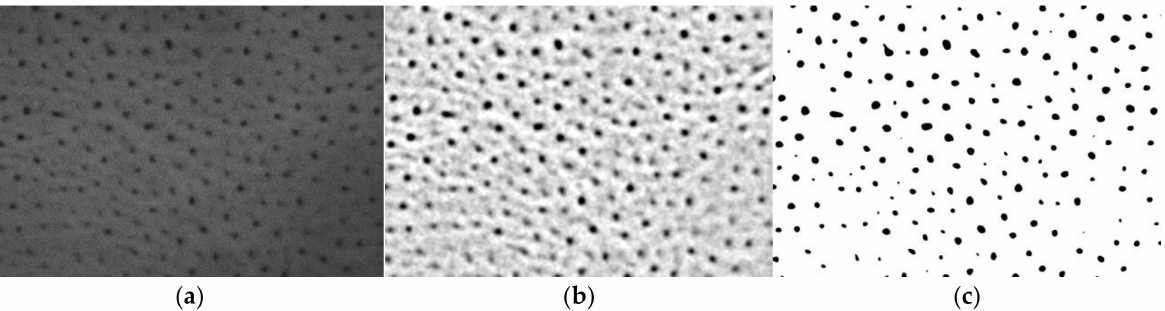
Figure 2. Stages of preparing SEM images for stereological analysis: ( a ) noise reduction in the image; ( b ) filtering the image in a band-like manner; ( c )